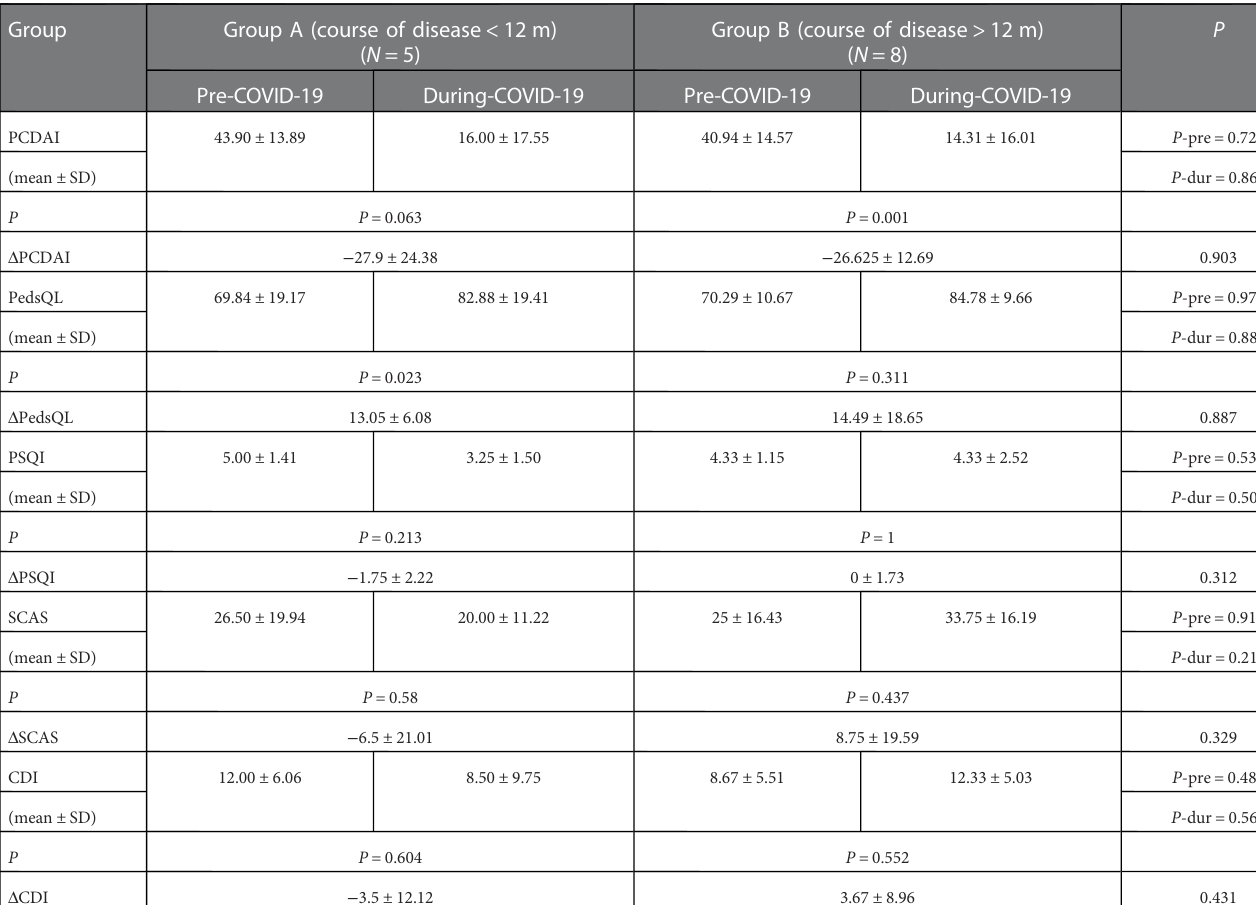
TABLE 3 Relationship between changes in disease activity and pedsQL, PSQI, SCAS and CDI before and during COVID-19 epidemic.